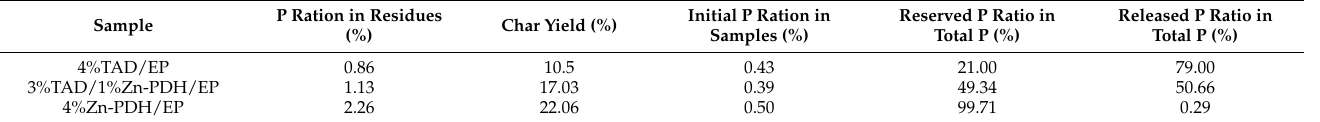
Table 7. Release before and after combustion and P content of the condensed phase.